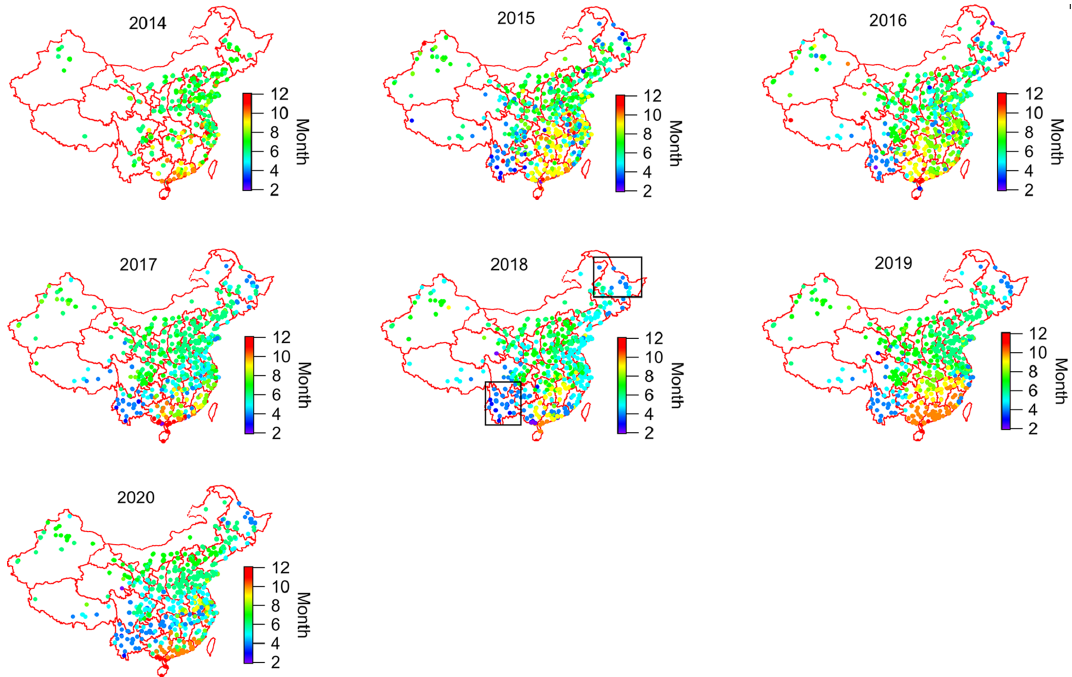
Figure 2. Spatial distribution of the month in which 3MMDA1 ozone (O 3 ) concentration occurred during 2014–2020. Rectangles included on the 2018 map in northeast and southwest China represent the Heilongjiang and Yunnan provinces, respectively.